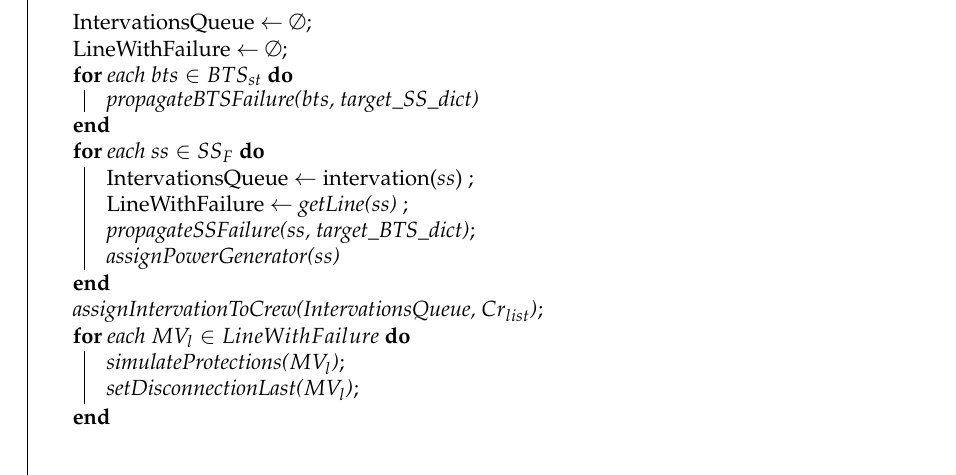
Figure A3. The simulation of protection devices